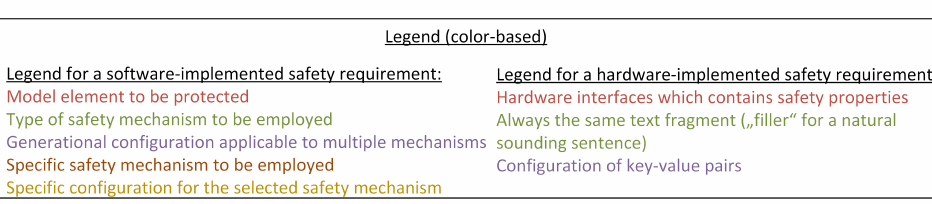
Figure 3. Derived safety requirements for the application